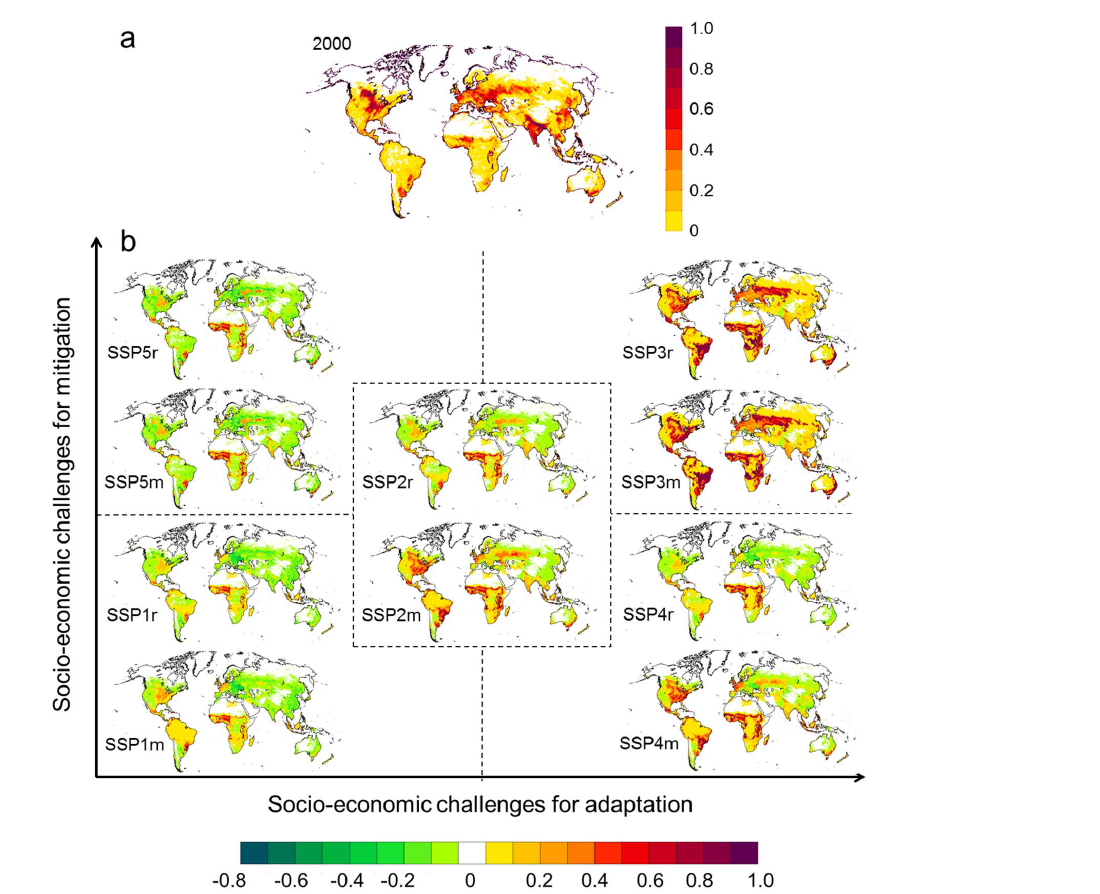
Figure 7. (a) Fraction of cropland on total land area for baseline year 2000 based on Hurtt et al. (2011). (b) Simulated cropland changes relative to baseline by 2100 for the five SSP reference (r) and mitigation (m) scenarios in the challenge for adaptation and mitigation space. Green colours indicate a decrease in cropland area in 2100 compared to 2000, while yellow and red colours indicate an increase in cropland area in 2100 compared to